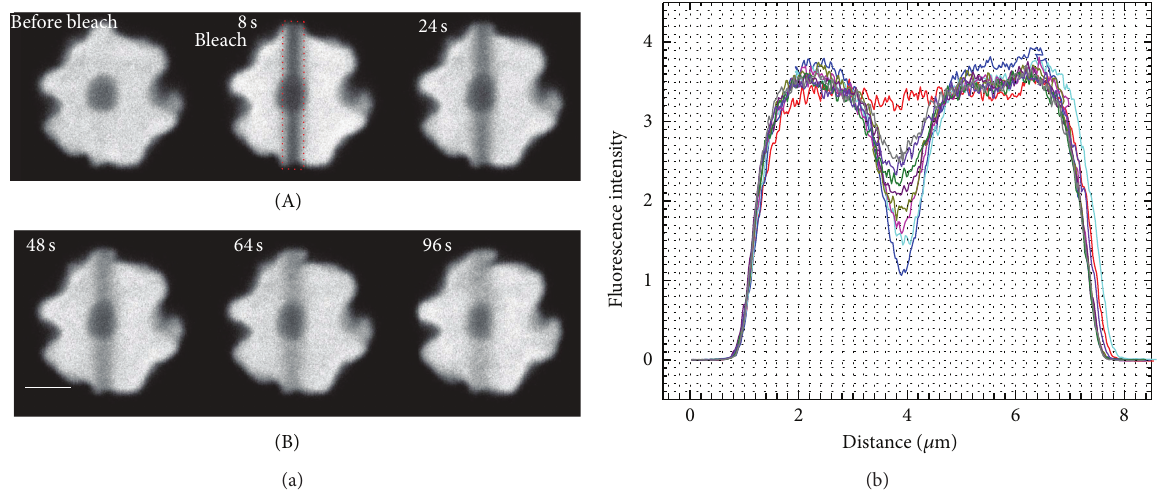
Figure 1: Experimental data from FRAP experiments [2, 3]. (a) Representative FRAP image sequence for a single cell of red algae Porphyridium cruentum for phycobilisome fluorescence. First, a fluorescence image before bleaching was detected ((A) before bleach), and then the phycobilisome fluorescence was bleached out across the middle of the cell in the vertical direction (red rectangle) and the postbleach images were recorded every 8 seconds (5 plots are displayed only). The total measurement time was 200 seconds; the length of the scale bar is 3 𝜇 m. (b) One-dimensional fluorescence profiles. The abscissa represents the position along the axis perpendicular to the bleach strip. The ordinate quantifies the corresponding values of fluorescence (in arbitrary units) averaged along the axis parallel to the bleach strip. In the central region we see the step-wise recovery of the Gaussian-shaped signals, from the lowest values of the first postbleach profile to the highest prebleach (steady-state) values on the